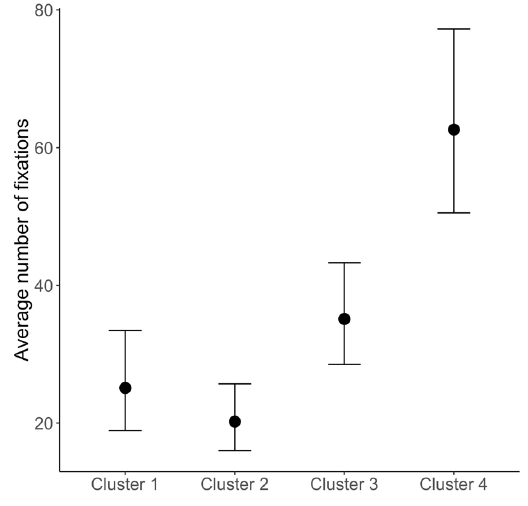
Figure 6. The average number of fixations of each group with 95 % credible